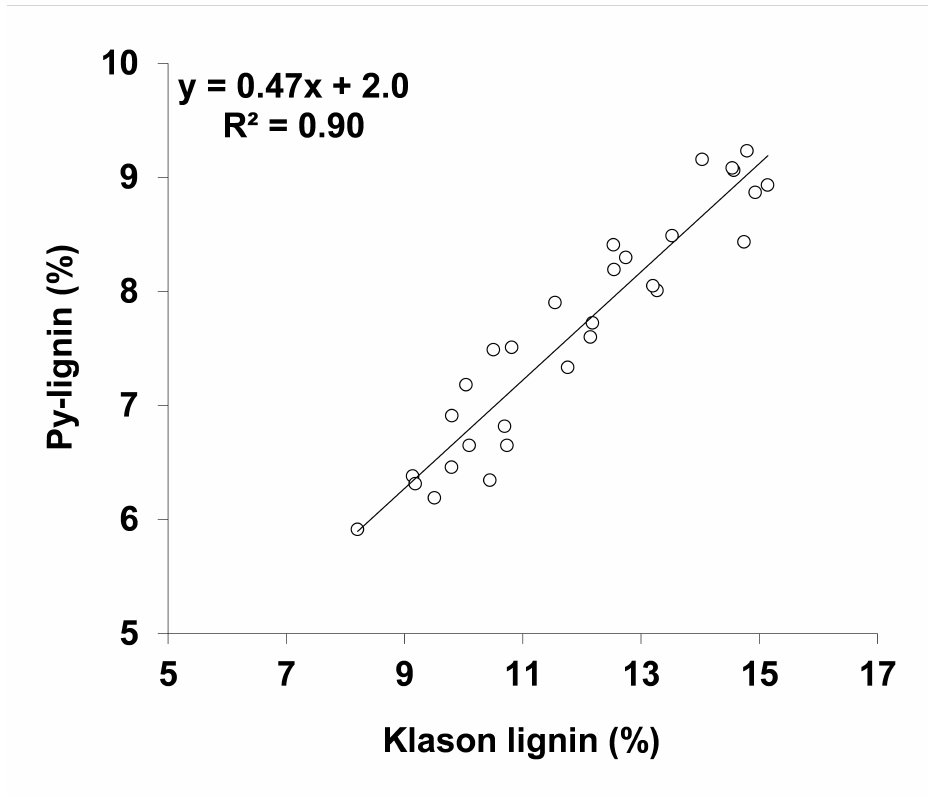
Figure 2. Scatterplot of the lignin content determined by pyrolysis versus reference Klason